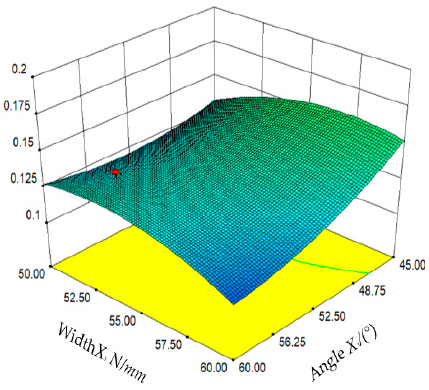
Figure 10. Angle–width response surface graph.